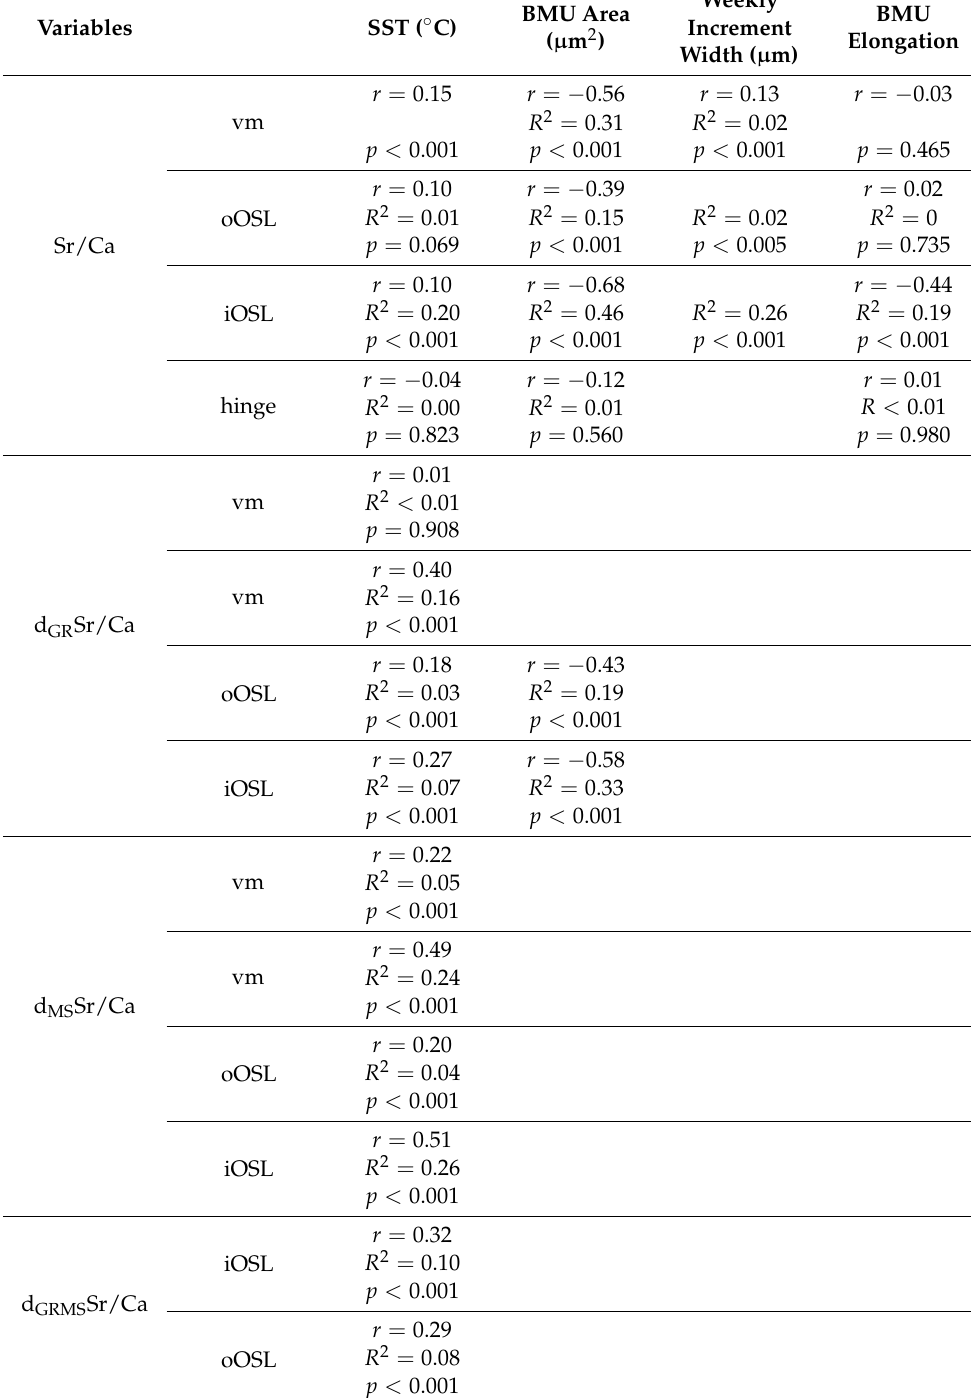
Table 2. Overview of the relationships (Pearson correlation; r = correlation coefficient; R 2 = coefficient of determination; p = probability) between the shell Sr/Ca data of Artica islandica and sea surface temperature (SST), biomineral unit (BMU) area and elongation and shell growth rate (weekly incre- ment width). The relationships were examined for undetrended Sr/Ca data of the outer and inner portions of the outer shell layer (oOSL and iOSL, respectively), as well as both sublayers combined (referred to as vm = ventral margin). Regression models were computed for Sr/Ca values detrended (d) for growth rate (d GR ) and BMU size (d MS )-related effects for the iOSL, oOSL and vm. Magenta vm = homogenous microstructure; green vm = crossed-acicular microstructure. d GRMS stands for double detrending. Weekly BMU BMU Area Increment Variables SST ( ◦ C) ( µ m 2 ) Width ( µ m) r = vm